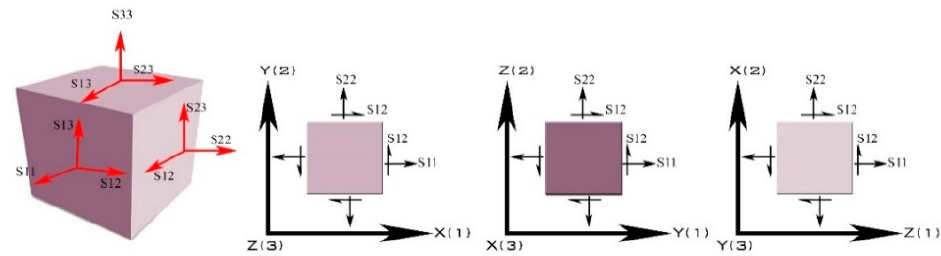
Figure 6. The sign criterion for the stress components.